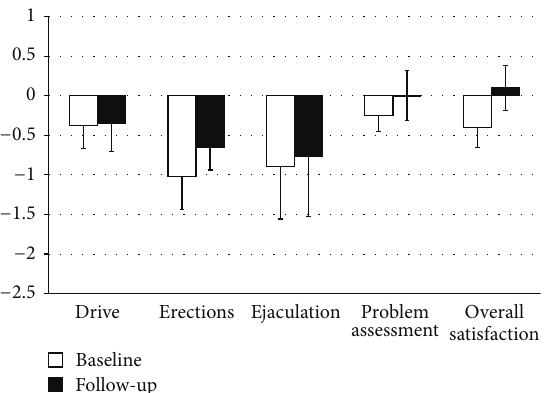
Figure 2: 𝑧 -scores (mean ± SEM scores) for the male Brief Sexual Function Inventory (BSFI) in male patients with congenital adrenal hyperplasia at baseline and after 2-year follow-up. Lower scores indicate higher levels of impairment. The control group has the 𝑧 -score value